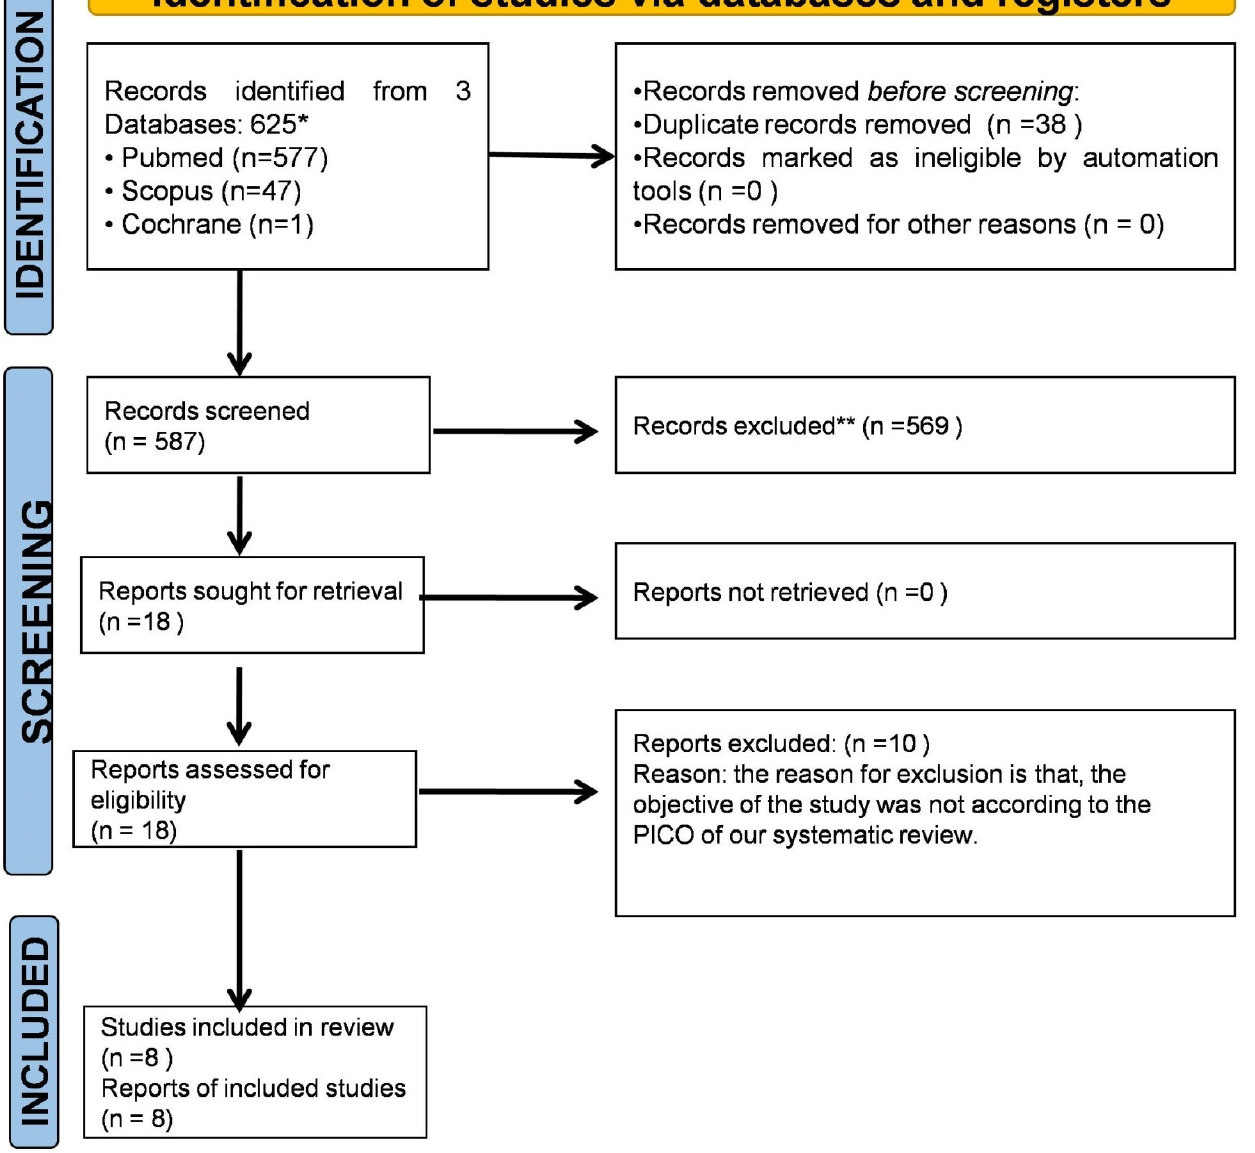
Figure 1. PRISMA 2020 flow diagram for new systematic reviews which included searches of databases and registers only. * Consider, if feasible to do so, reporting the number of records identified from each database or register searched (rather than the total number across all databases/registers).